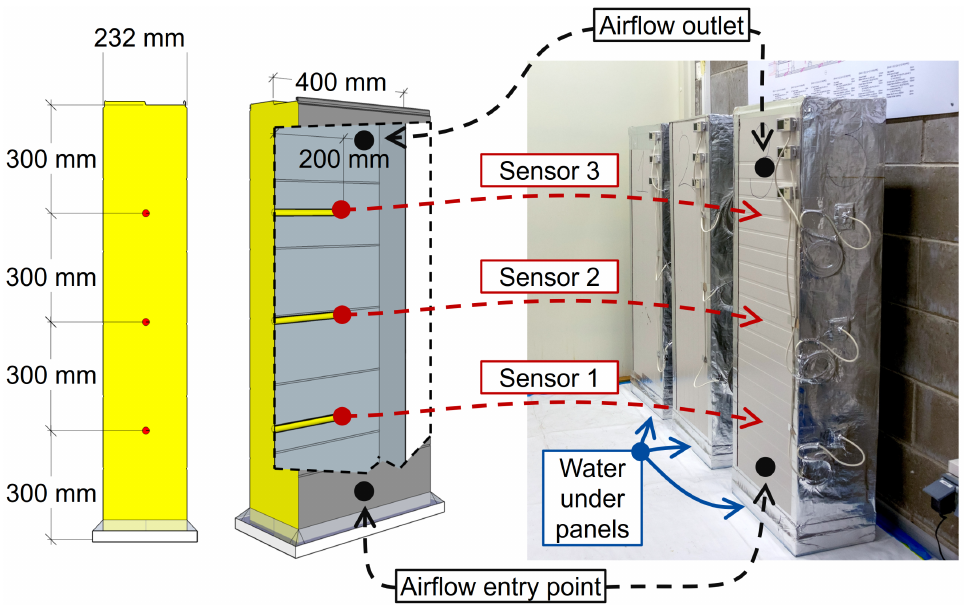
Figure 1. 3D mock-up test elements: (a) with indicated T and RH sensor placement (red dots, Hobo UX-100-023), airflow sensors (black dots SMC PFM 710) and photos of the elements (b).